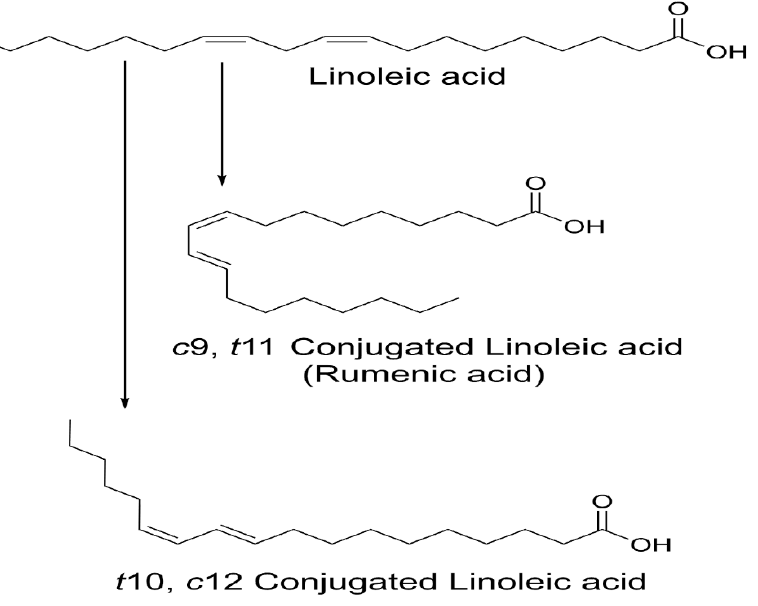
Figure 1. Structure of linoleic acid (LA), c 9, t 11 and t 10, c